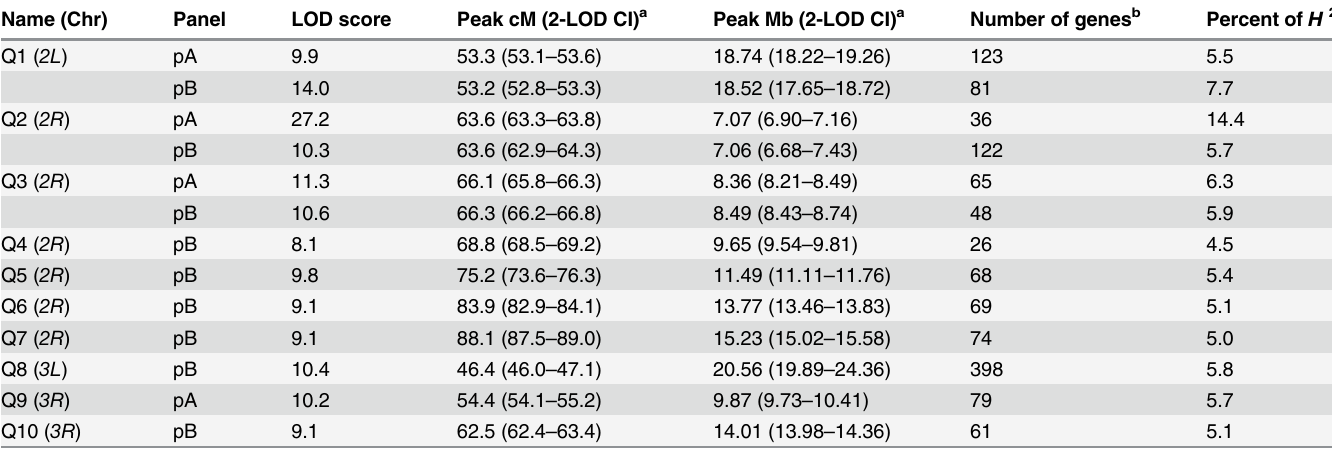
Table 1. Details of mapped caffeine resistance QTL. Name